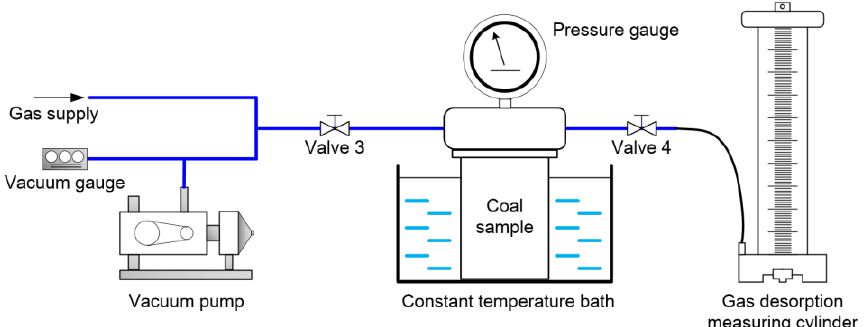
Figure 3. Schematic diagram showing the set-up used for the gas desorption experiments.